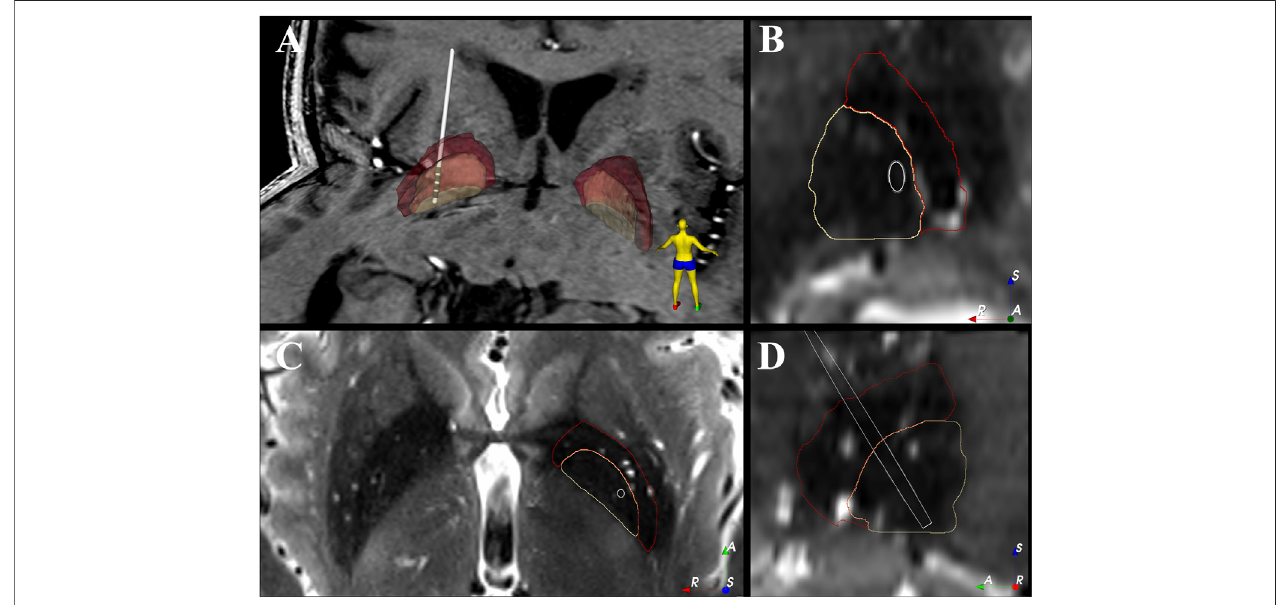
FIGURE 1 | Electrode location within the patient ’ s GPi. (A) 3D view of the electrode location against the patient ’ s 7T T1 image. (B – D) show the coronal, axial and sagittal view of the electrode location against the patient ’ s 7T T2 image. The 2D images are shown in “ left is right ” orientation. White = electrode shaft, grey = electrode contact, beige = GPi, red = GPe, A = anterior, R = right, S = superior.